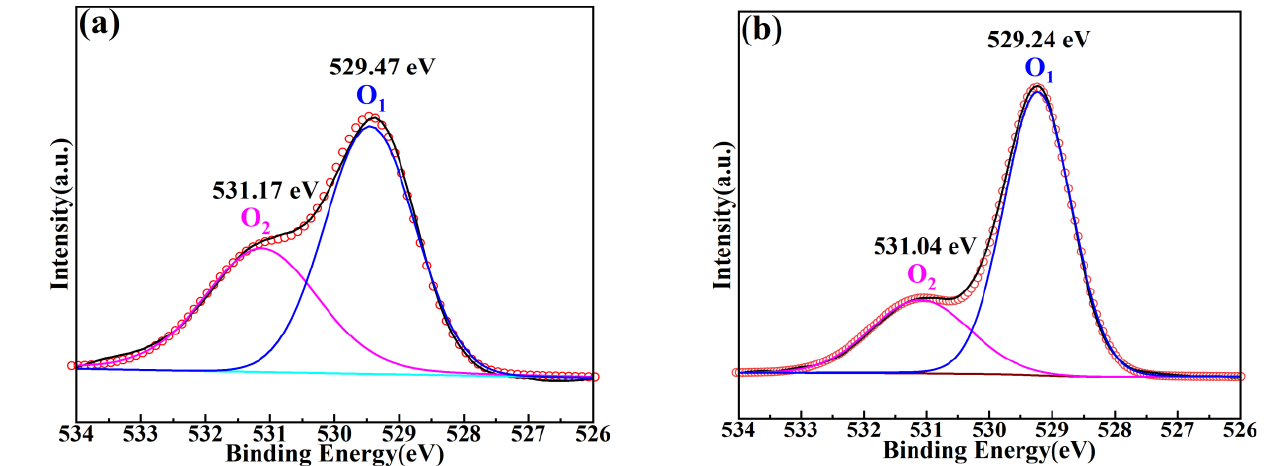
Figure 6. XPS spectra of O 1s for ( a ) undoped sample and ( b ) the sample with x = 0.2.